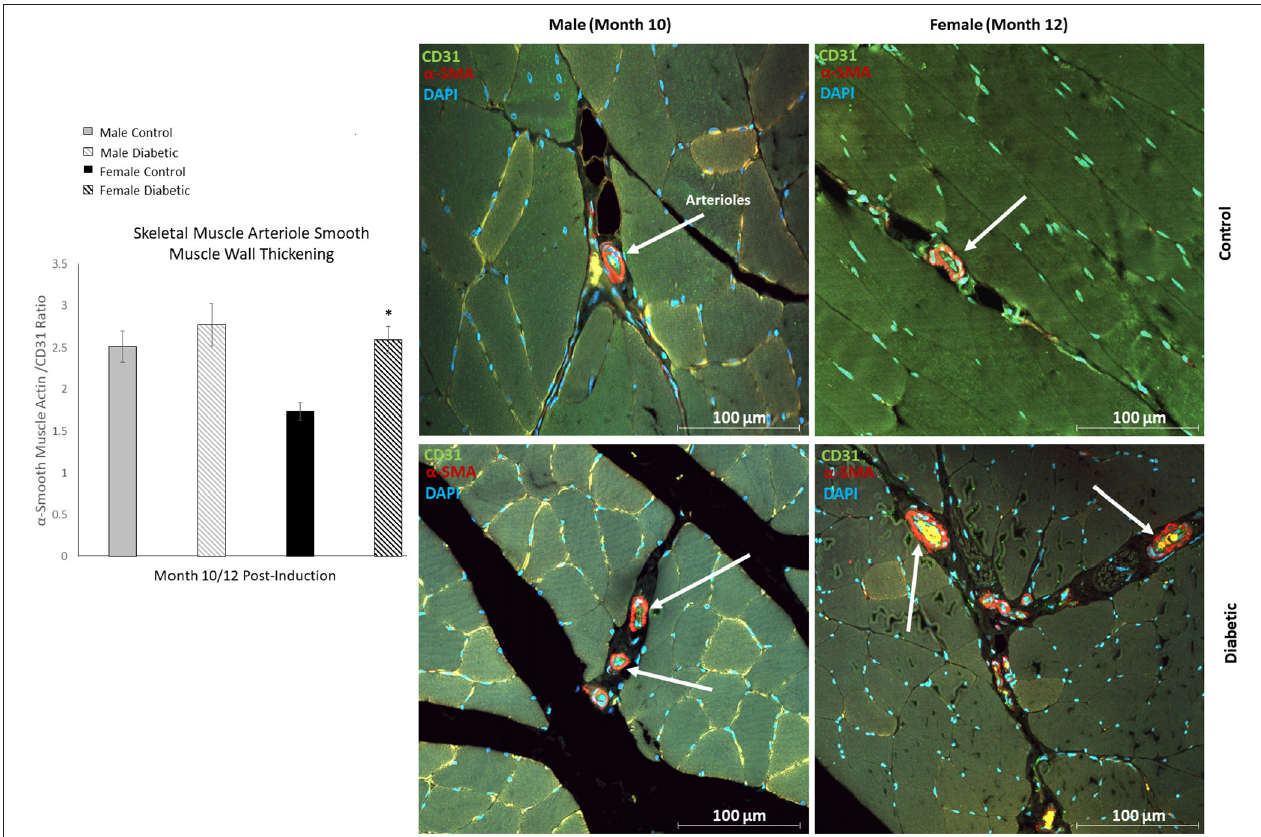
FIGURE 4 | Immunofluorescence of small arteriole perivascular smooth muscle wall in leg skeletal muscle shows thickening in diabetic females. Quantification expressed as a ratio of surface area coverage of α SMA to CD31 for each arteriole (10–25 µ m). Assessment conducted at 10 and 12 months post-induction for males and females, respectively ( n = 3 control male, n = 4 diabetic male, n = 3 control female and n = 4 diabetic female). White arrows highlight representative arterioles from each cohort. Significance between control and diabetic cohorts with their respective sex is indicated (* p < 0.05). Data represented as mean ± SEM.